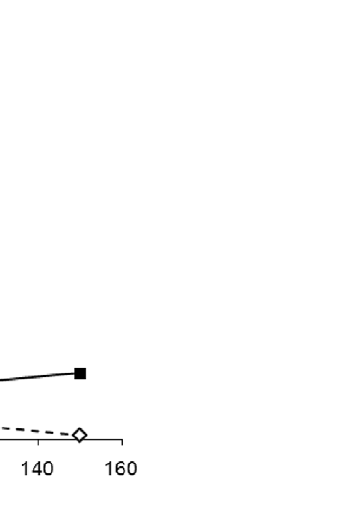
Figure 4. The coupling capacity of the sub-populations of the V H + -ATPase molecules inactivated by growing concentrations of nitrate. For each nitrate concentration, the coupling ratio was calculated by dividing the difference of the initial velocities of H + transport (V 0 ) for neighbouring concentrations by the similar difference in ATP hydrolysis. The enzymes exhibiting the highest coupling capacity of activated and non- activated states were inhibited by 5 mM nitrate in presence of 50 mM KCl. An example of the calculations: (V 0 at 0 mM nitrate – V 0 at 5 mM):(ATPase at 0 mM – ATPase at 5 mM).